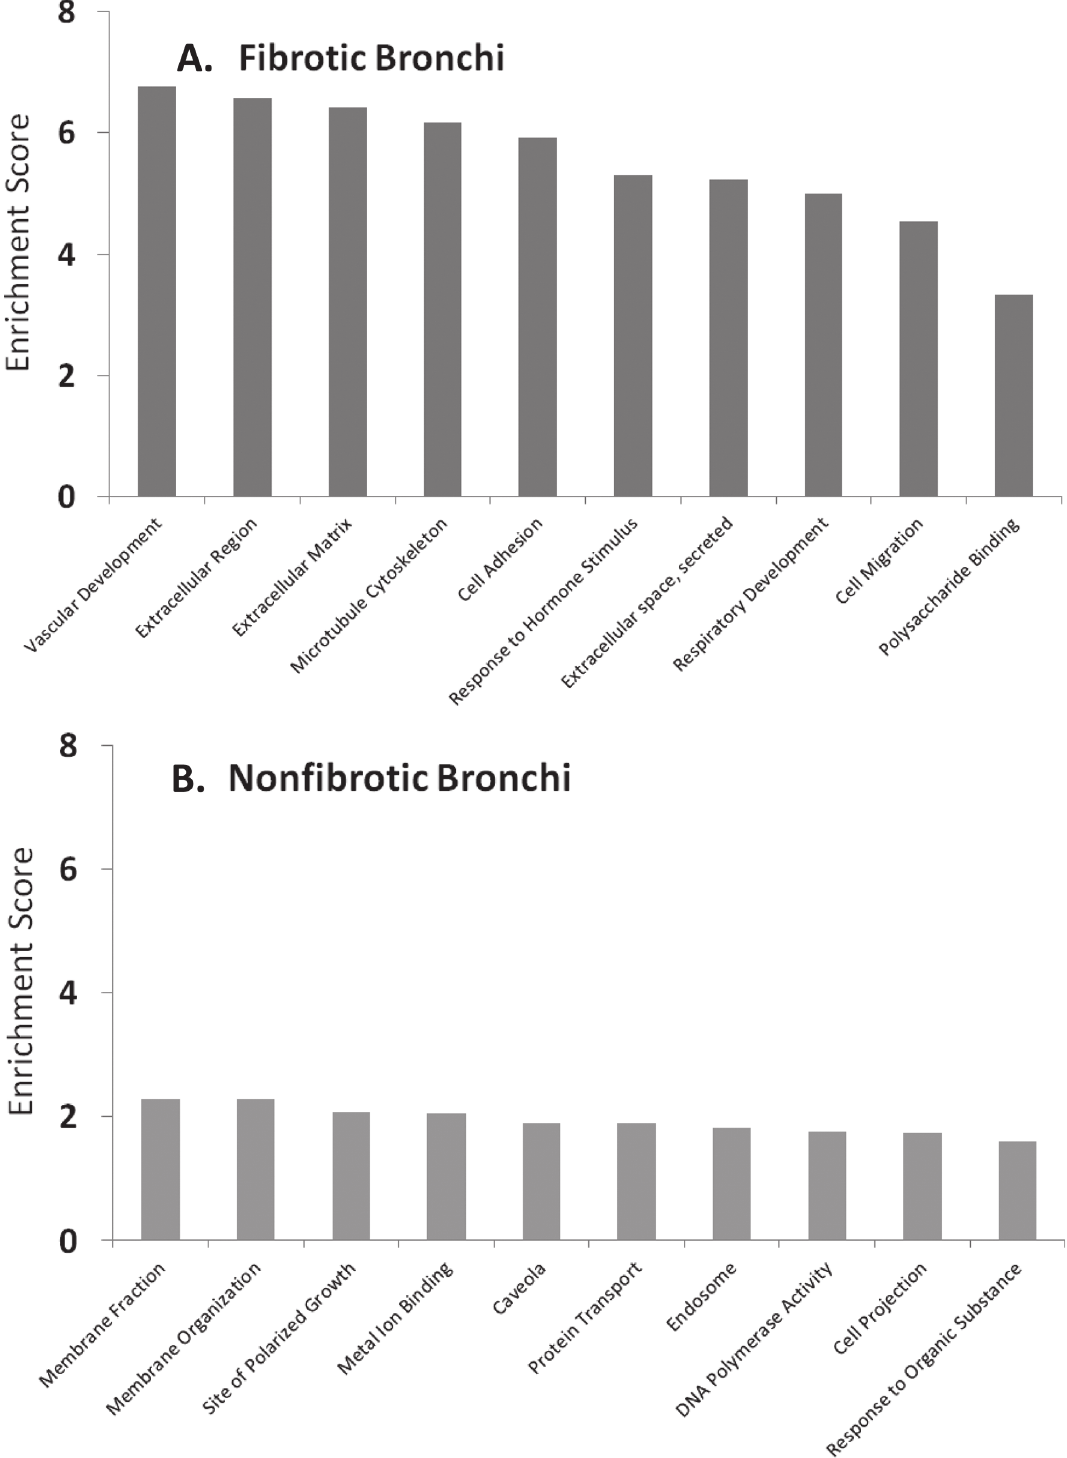
Fig 4. Enriched biological processes. Differentially expressed transcripts from fibrotic bronchi (A) or exposed, non-fibrotic bronchi (B) were enriched for biological processes and cellular functions using the DAVID functional annotation tool. The combined enrichment score is shown on the y-axis for each of the top ten biological categories on the